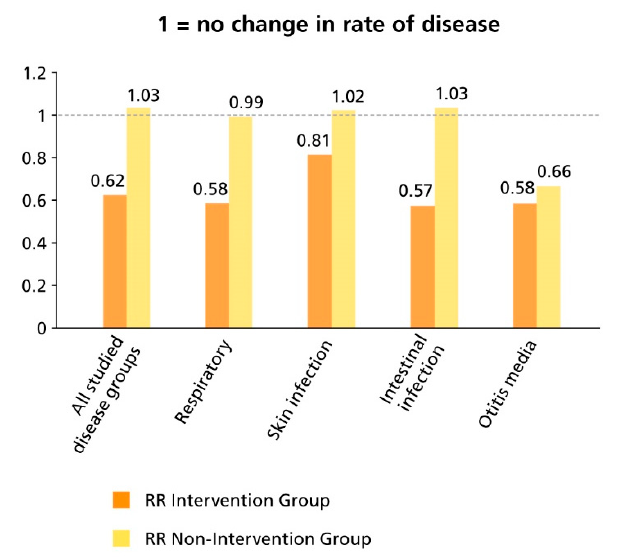
Figure A1. Before and after rate ratios for disease conditions in HfH intervention and non-intervention groups during a Health Outcomes Evaluation of Housing for Health.Source: Aboriginal Environmental Health Unit, Closing the Gap: 10 Years of Housing for Health in NSW—An evaluation of a healthy housing intervention. 2010: Sydney, NSW.